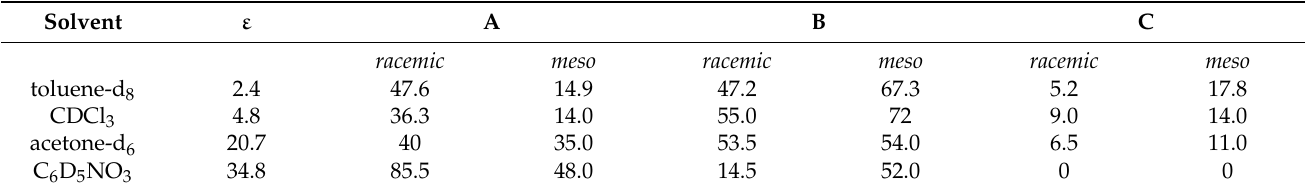
Table 3. Solvent dependence of rotamers content for both diastereomers of 1 at 21.5 ◦ C.